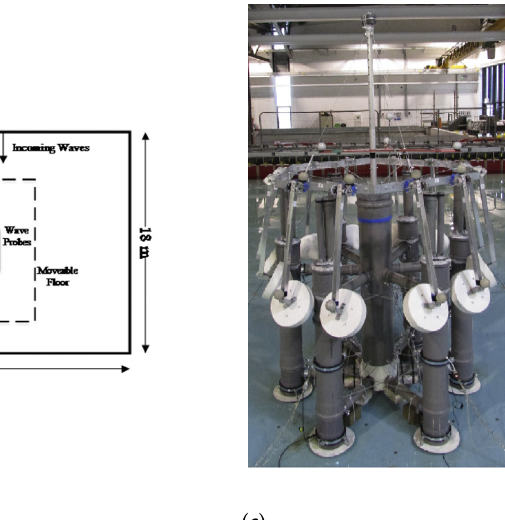
Figure 16. Experimental setup used by Kamarlouei et al., reprinted with permission from Ref. [53], 2020, Kamarlouei et al.: ( a ) conceptual design; ( b ) Lir’s Ocean Basin WEC array layout; ( c ) model of the concentric WEC array installed on a floating offshore